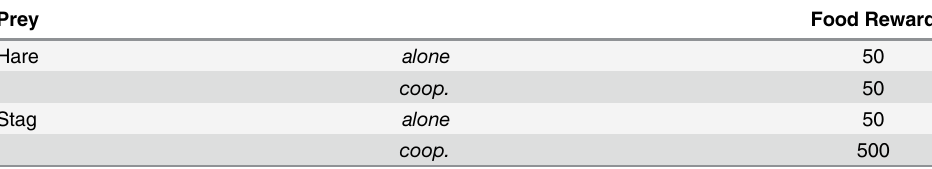
Table 3. Food rewards for hunting different prey. Prey